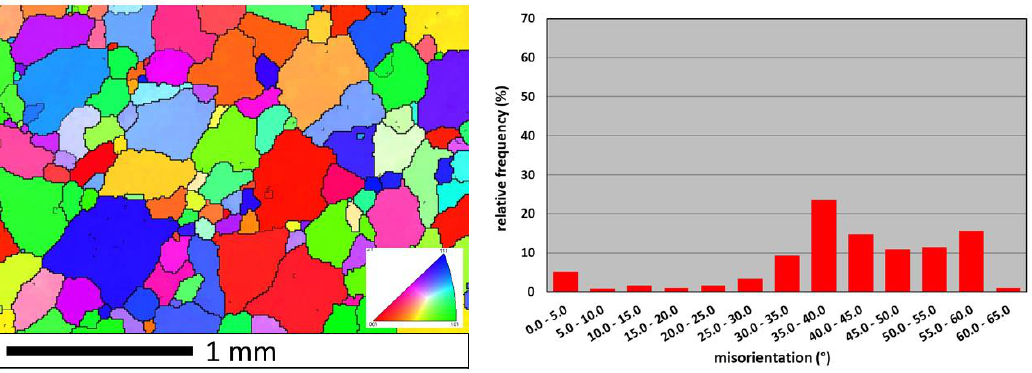
Figure 2. Orientation map and misorientation distribution for FeAl as-cast alloy: thick lines – high angle boundaries (HABs) (misorientation > 15°); thin lines – low angle boundaries (LABs) (misorientation < 15°); color interpretation according to the stereographic triangle (red <001> direction, green <110> direction, blue <111> direction).